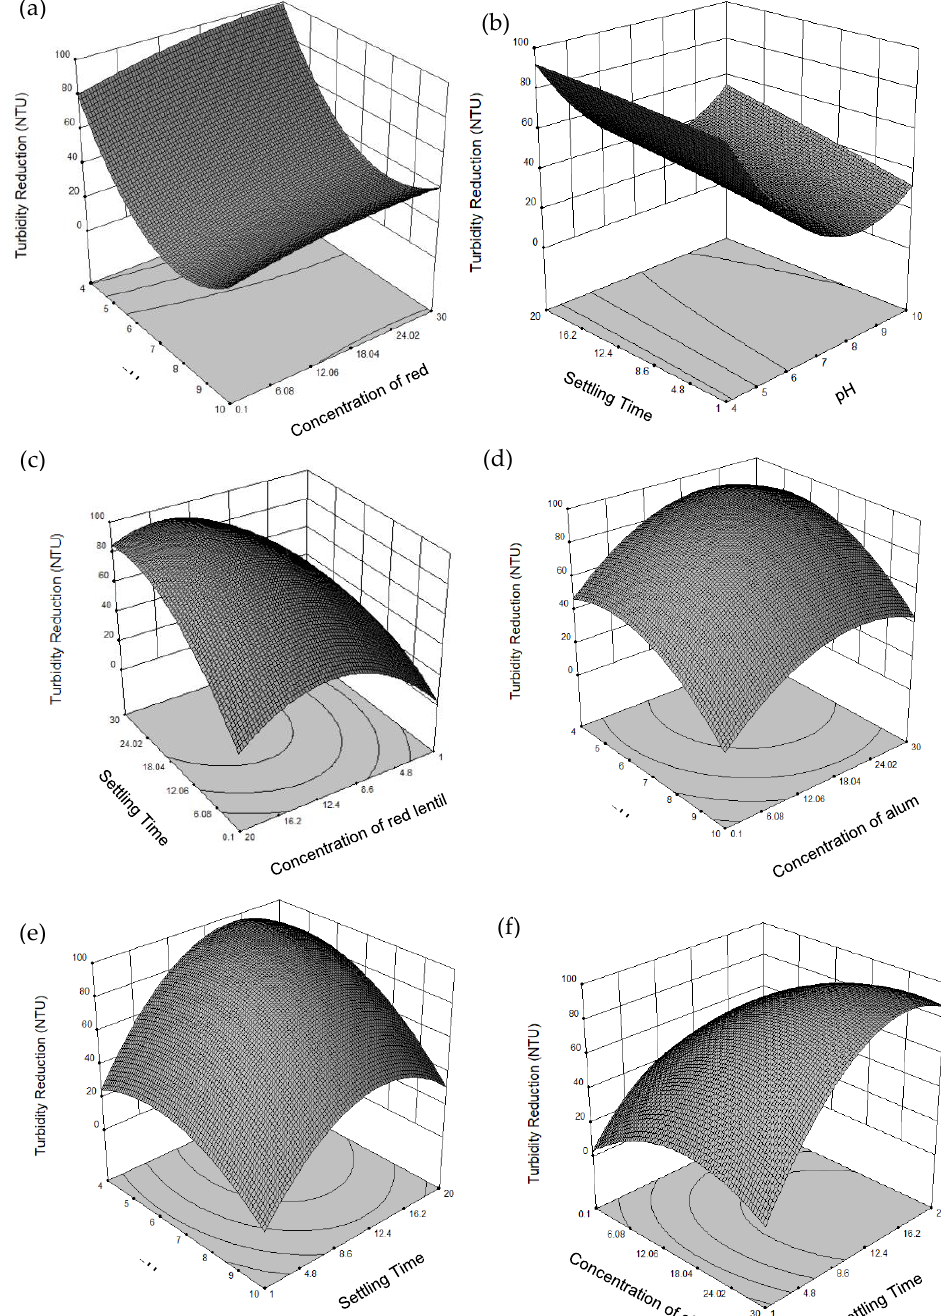
Figure 5. 3D surface plots for turbidity reduction (%) by using red lentil extract as coagulant and alum as coagulant: ( a , d ) effect of pH and concentration of coagulant (mg/L); ( b , e ) effect of settling time (mins) and pH; ( c , f ) effect of settling time and concentration